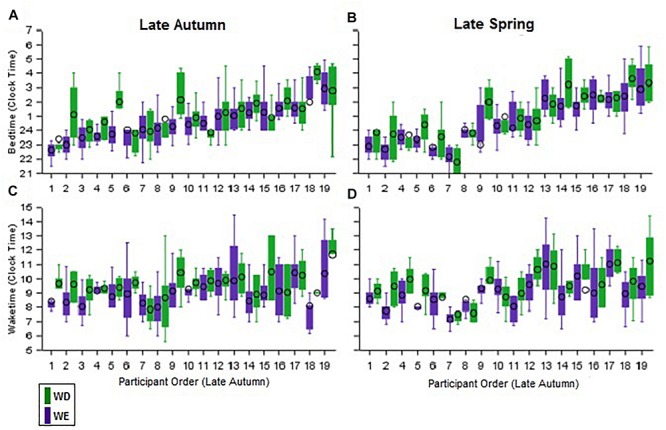
Inter individual differences and intra-individual stability in bed and wake times during weekdays and weekend in the late autumn and late spring. The daily bedtimes of participants during both seasons are shown as boxplots in the two upper panels (A,B) while the corresponding wake-times are shown in the two lower panels (C,D). The purple boxplots represent weekdays and the green boxplots the weekend days. Participants in all four panels are ordered from earliest to latest weekday autumn bedtimes.